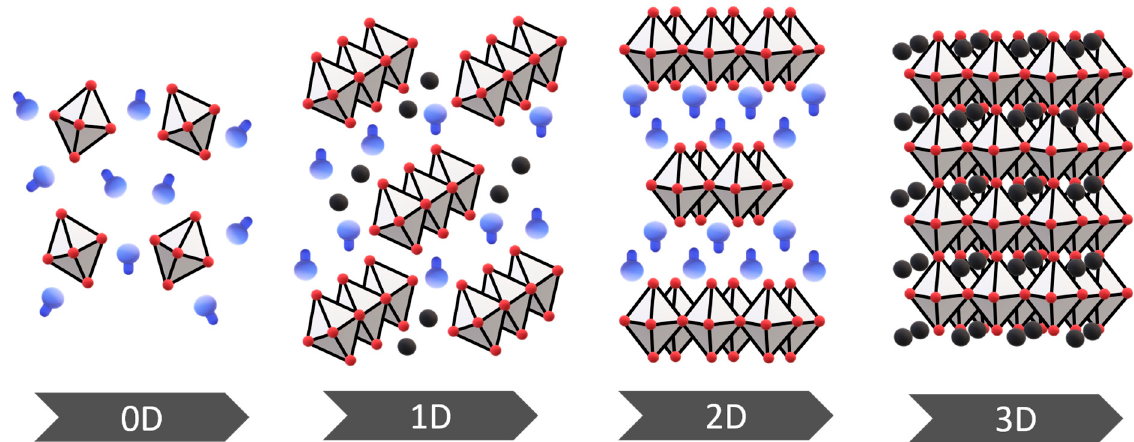
Figure 3. Schematic illustration of perovskite-related materials for different dimensionalities (Black: cation A; Red: anion X; Blue: cation A’ with larger radius).